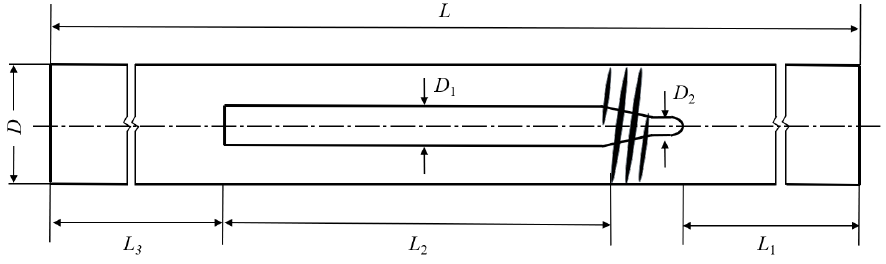
Figure 3. Entire computational domain. L = 2170 mm, L 1 = 800 mm, L 2 = 300 mm, L 3 = 1000 mm, D = D 0 + 2 τ , D 1 = 35.5 mm, D 2 = 15.5 mm.